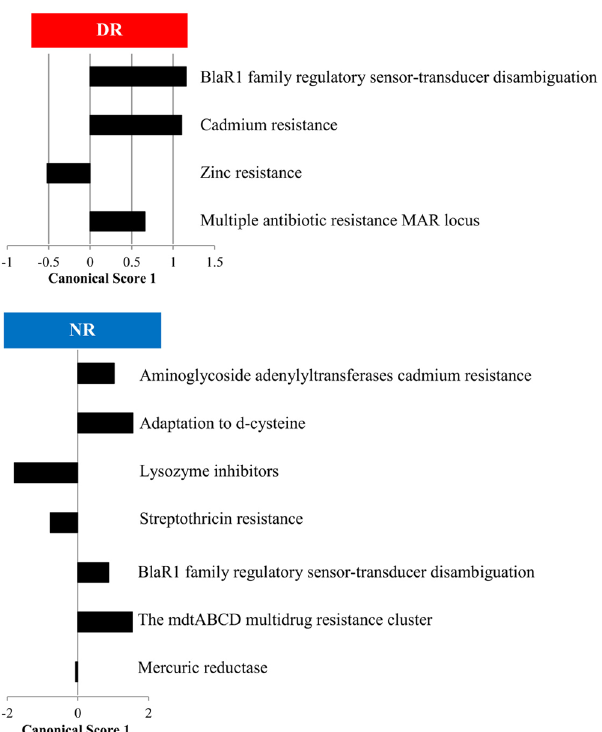
Figure 6. Canonical scores for RATC profile that were found to be significant for the discriminant analysis displayed in Fig.